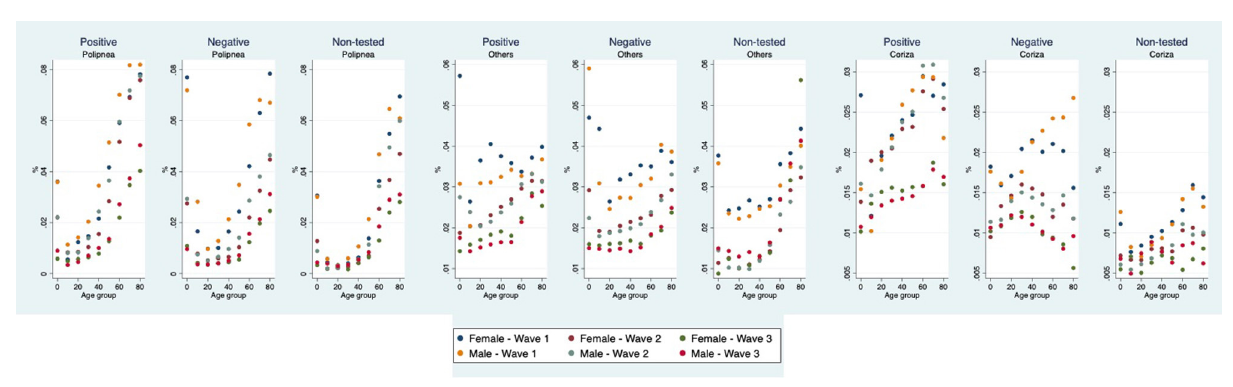
FIGURE1 Prevalence of signs and symptoms among those with COVID-like-symptoms that were positive, negative or not-tested for SARS-CoV-2 by wave, age group, and